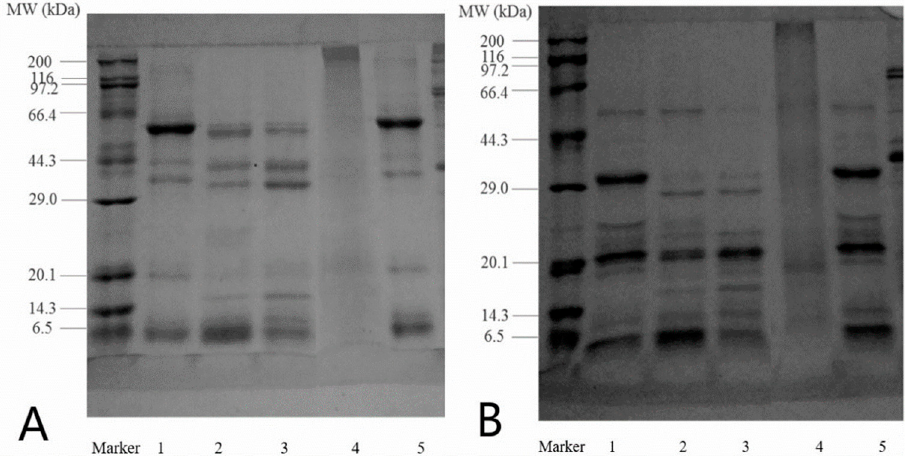
Figure 1. Non-reducing ( A ) and reducing ( B ) SDS-PAGE profiles of cashew nut proteins. (Lane 1, DCNF; Lane 2, albumin; Lane 3, globulin; Lane 4, glutelin; Lane 5, CNPI). The molecular weights of markers are 6.5, 14.3, 20.1, 29.0, 44.3, 66.4, 97.2, 116 and 200 kDa, respectively.